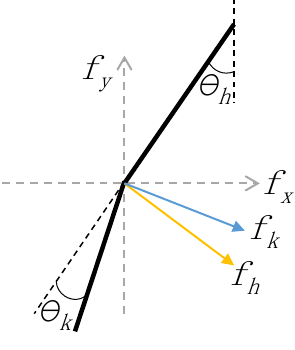
Figure 5. Abstraction of lower limbs and the force in knee board. Where the black line is the abstract of thigh and shank; f x and f y represent the sagittal coordinate system; f h and f k are the forces in the hip and knee joints, respectively; and θ h and θ k are the angles of hip and knee joints,